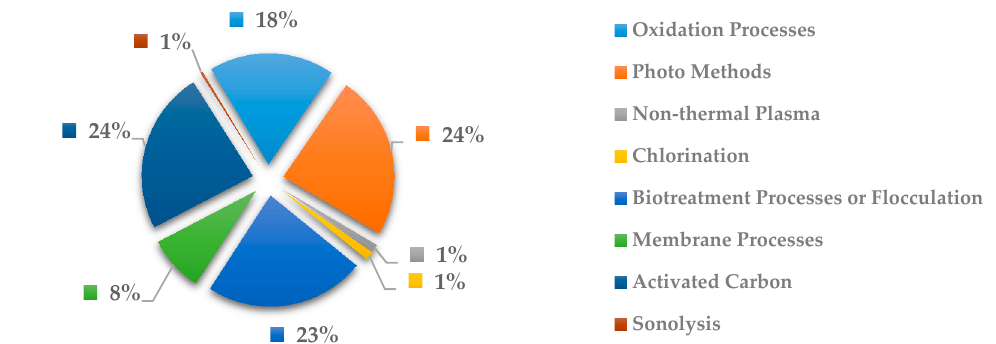
Figure 25. Percentage of scientific articles worldwide regarding wastewater treatments of anti-inflammatory drugs between 1998 and 2020. Data collected in Scopus database by using wastewater or water as keywords and English as a language limitation.